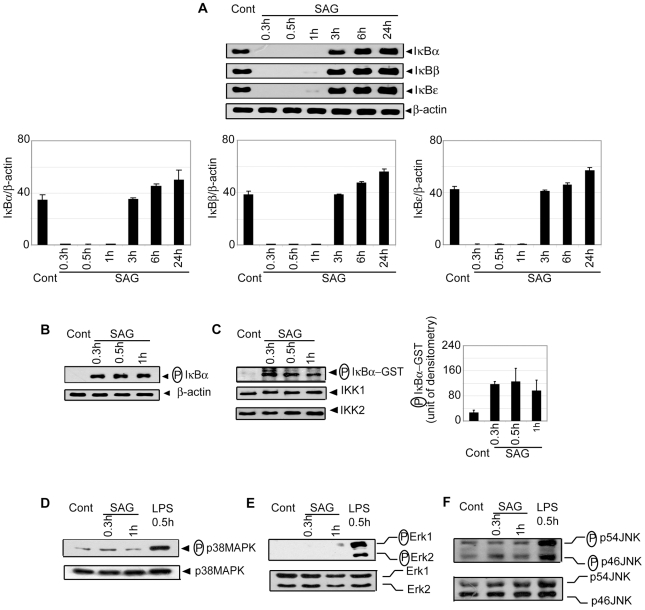
SAG-treated BMDCs exhibit increased phosphorylation and degradation of IκB proteins and IKK activity.BMDCs were untreated or stimulated either with 20 µg/ml SAG (A-F) or 500 ng/ml LPS (D-F) for specified times. (A) Expression of IκBα, IκBβ, IκBε and β-actin protein in cytoplasmic extracts was detected by Western blot using the same blot. Densitometric analyses represent the ratio of intensity of the corresponding IκB protein to β-actin expression per unit area and are represented as an arbitrary unit. (B) Cytoplasmic phospho-IκBα versus β-actin protein expression was detected via Western blot with the same blot. (C) In vitro IKK activity was determined by measuring phosphorylation of an IκBα-GST substrate. IKK1 and IKK2 protein expression in immunoprecipitated samples was analyzed via Western blot. Densitometric analysis indicates the intensity of phosphorylated (P) IκBα-GST substrate in an arbitrary unit. The levels of (D) phospho-p38MAPK versus p38MAPK, (E) phospho-ERK versus ERK and (F) phospho-JNK versus JNK protein expression in whole cell lysates were determined via Western blot. Data are representative of three independent experiments. Error bars indicate mean ± SD.